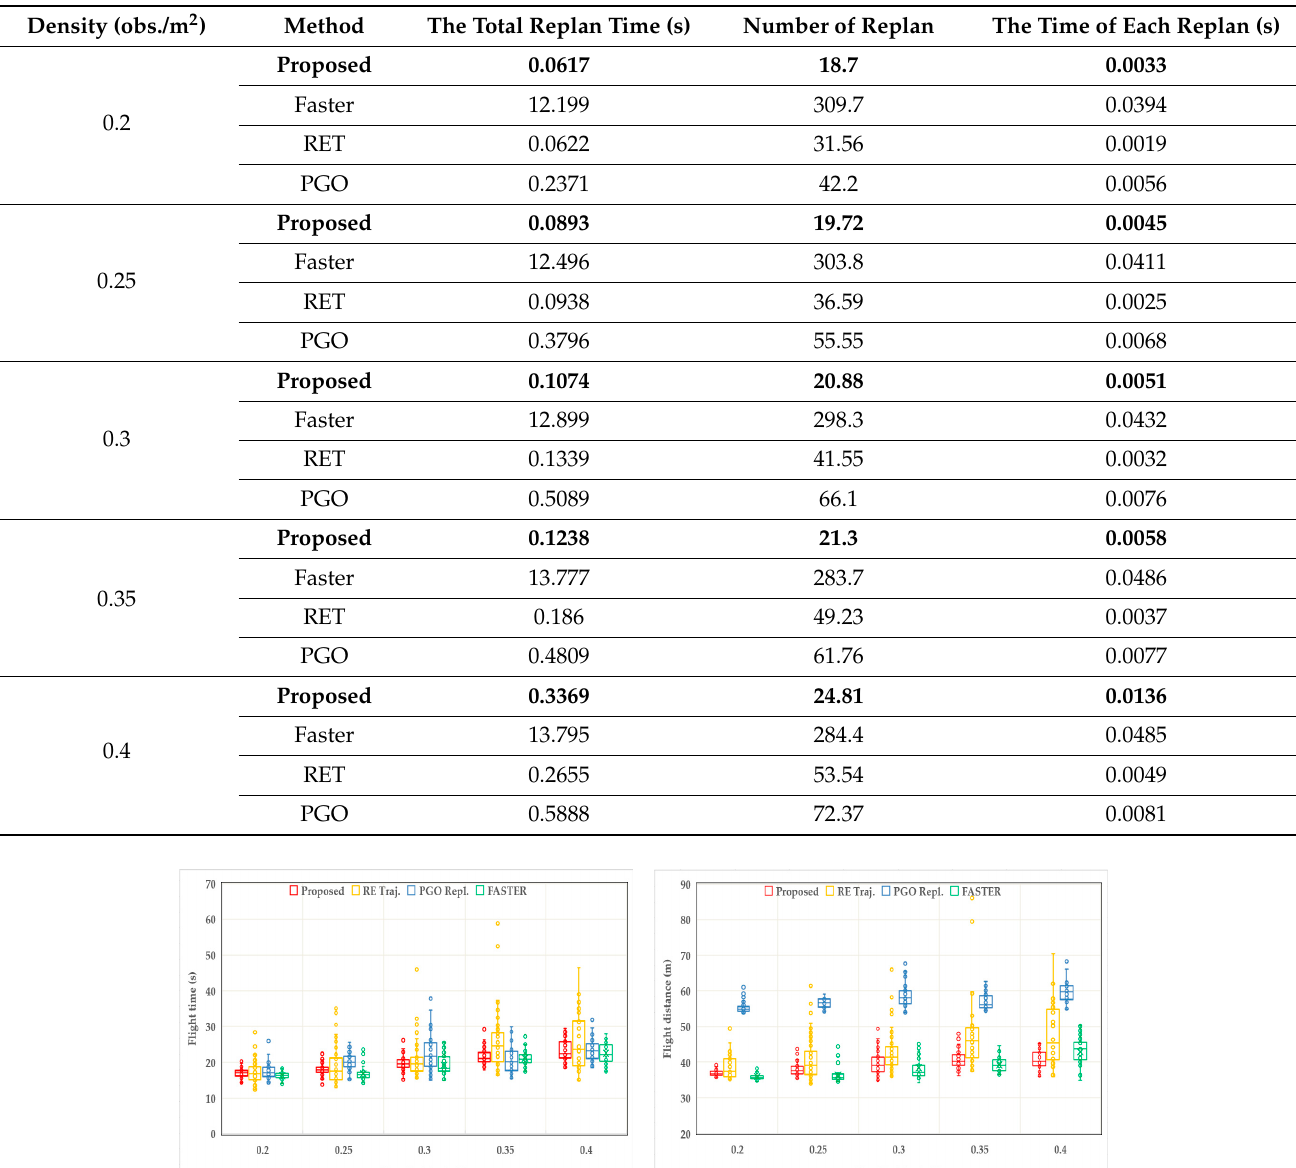
Table 1. The comparisons of three planning methods in Replan.